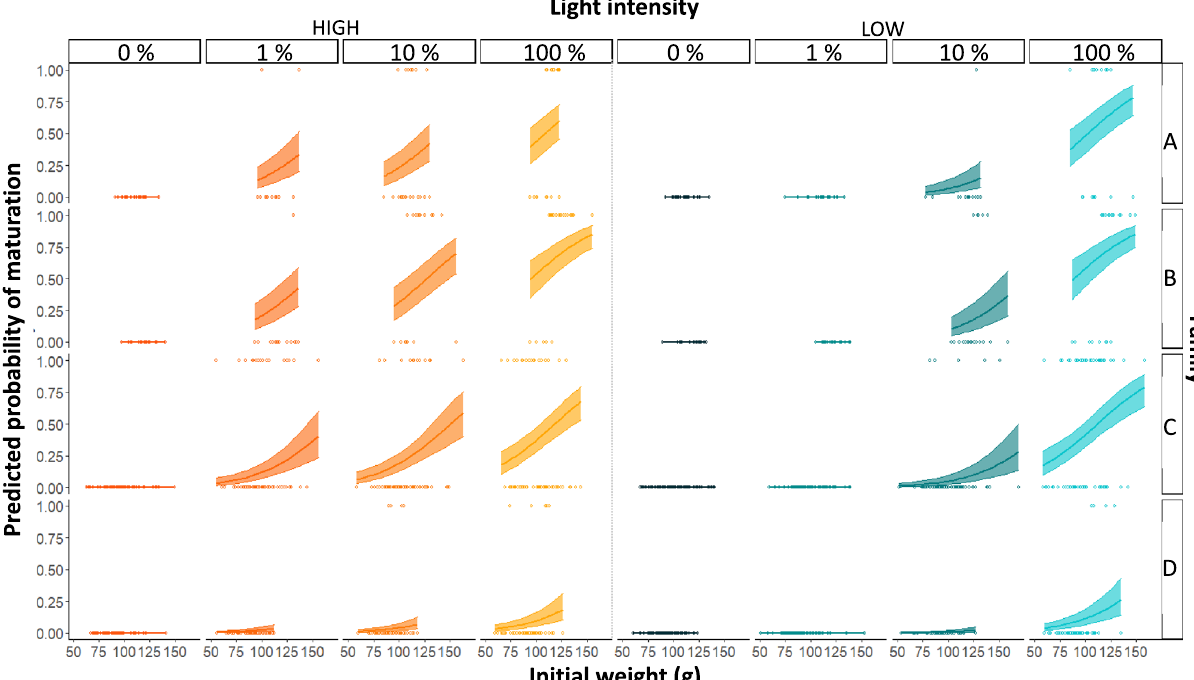
Figure 3. Impact of light treatment, family and initial weight on probability of maturation. Solid lines and shaded areas display the fitted values ± 95% confidence intervals from the generalized linear mixed model. High light intensity groups are presented in orange, while the low light intensity groups are presented in green. Individual data points are presented as open circles.